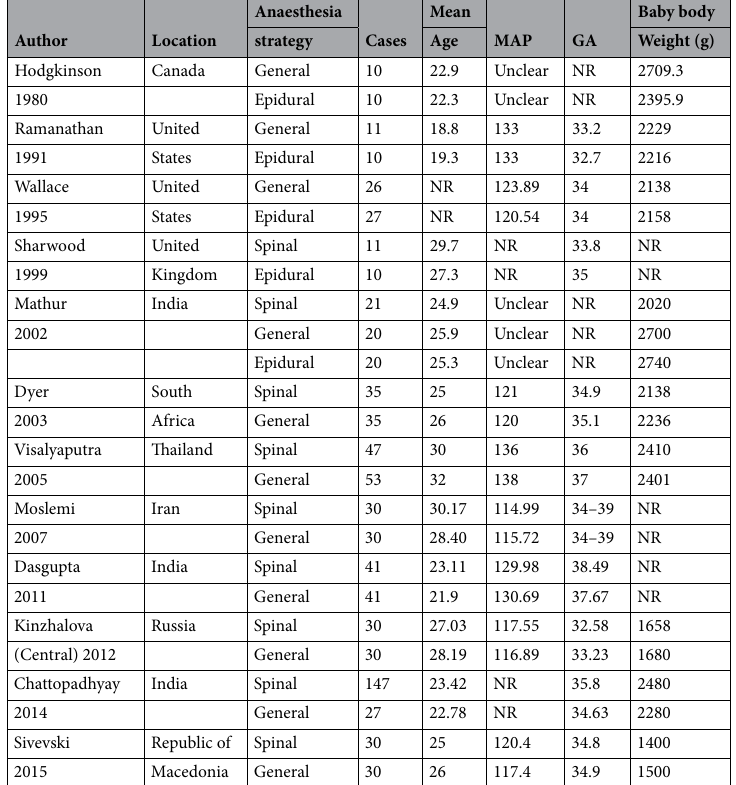
Table 1. Characteristics of the included clinical trials. GA gestational age, MAP mean artery pressure, NR no